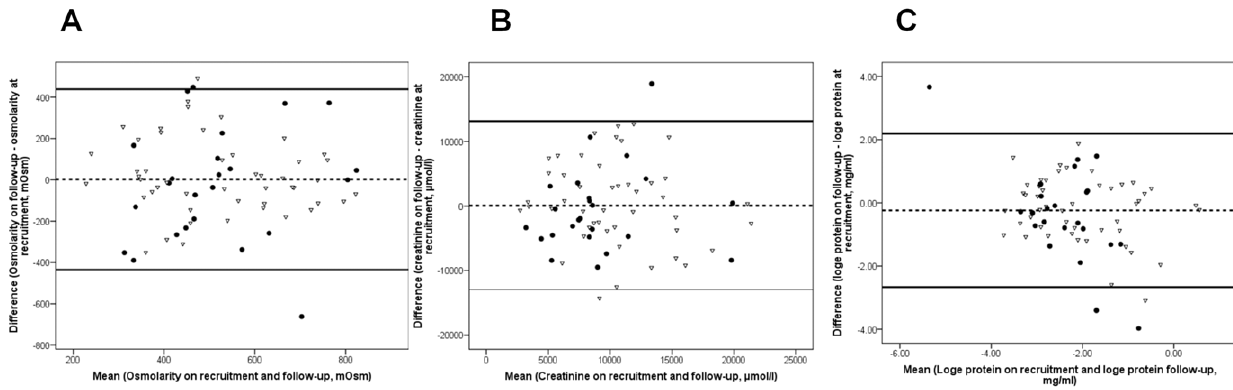
Figure 5. Bland Altman plots for osmolarity, creatinine and protein. Bland Altman plots for (A) osmolarity; (B) creatinine; and (C) protein (log e ) were plotted to determine the agreement between the levels of each standard measured on recruitment and those measured at follow-up. The hashed line (mean of the mean differences) demonstrates that protein levels decreased by approximately 24% at follow-up. Osmolarity and creatinine levels did not significantly change. Solid lines, 95% CI limits. Open triangles (bladder cancer); closed black circles (controls).